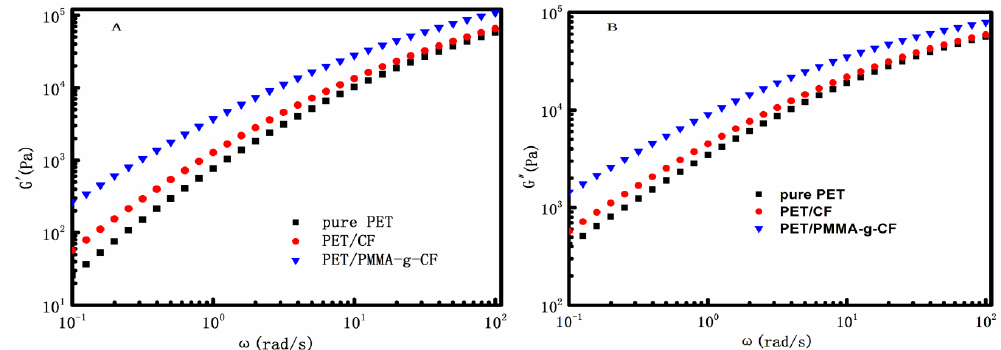
Figure 6. ( A ) Storage modulus (G ′ ), and ( B ) loss modulus (G ′′ ) as a function of the frequency of pure PET, PET/CF, and PET/PMMA-g-CF composites.